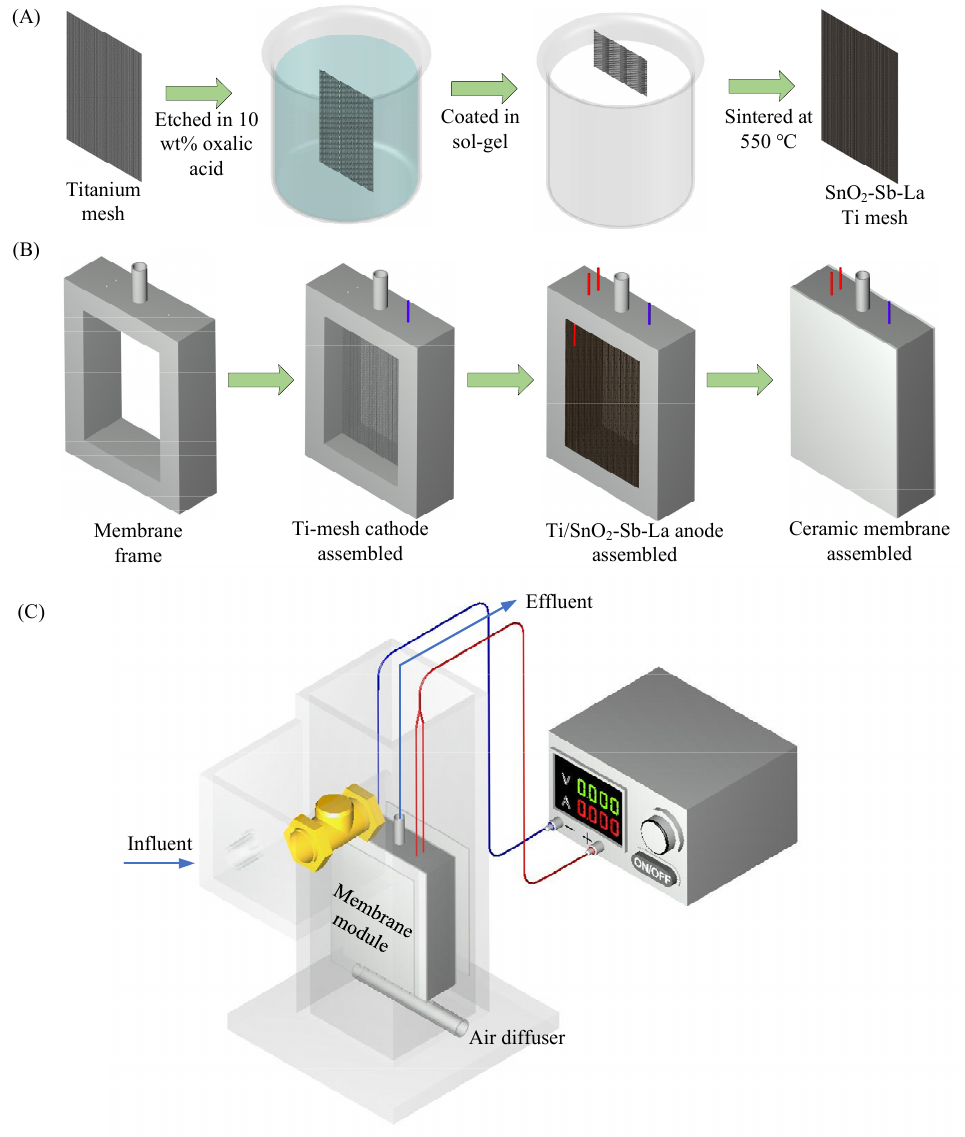
Figure 1. Schematic of ( A ) the fabrication process of the Ti / SnO 2 -Sb-La electrode and ( B ) assembly of the electrochemical ceramic membrane module; ( C ) schematic of electrochemical ceramic membrane bioreactor (ECMBR) for wastewater treatment.